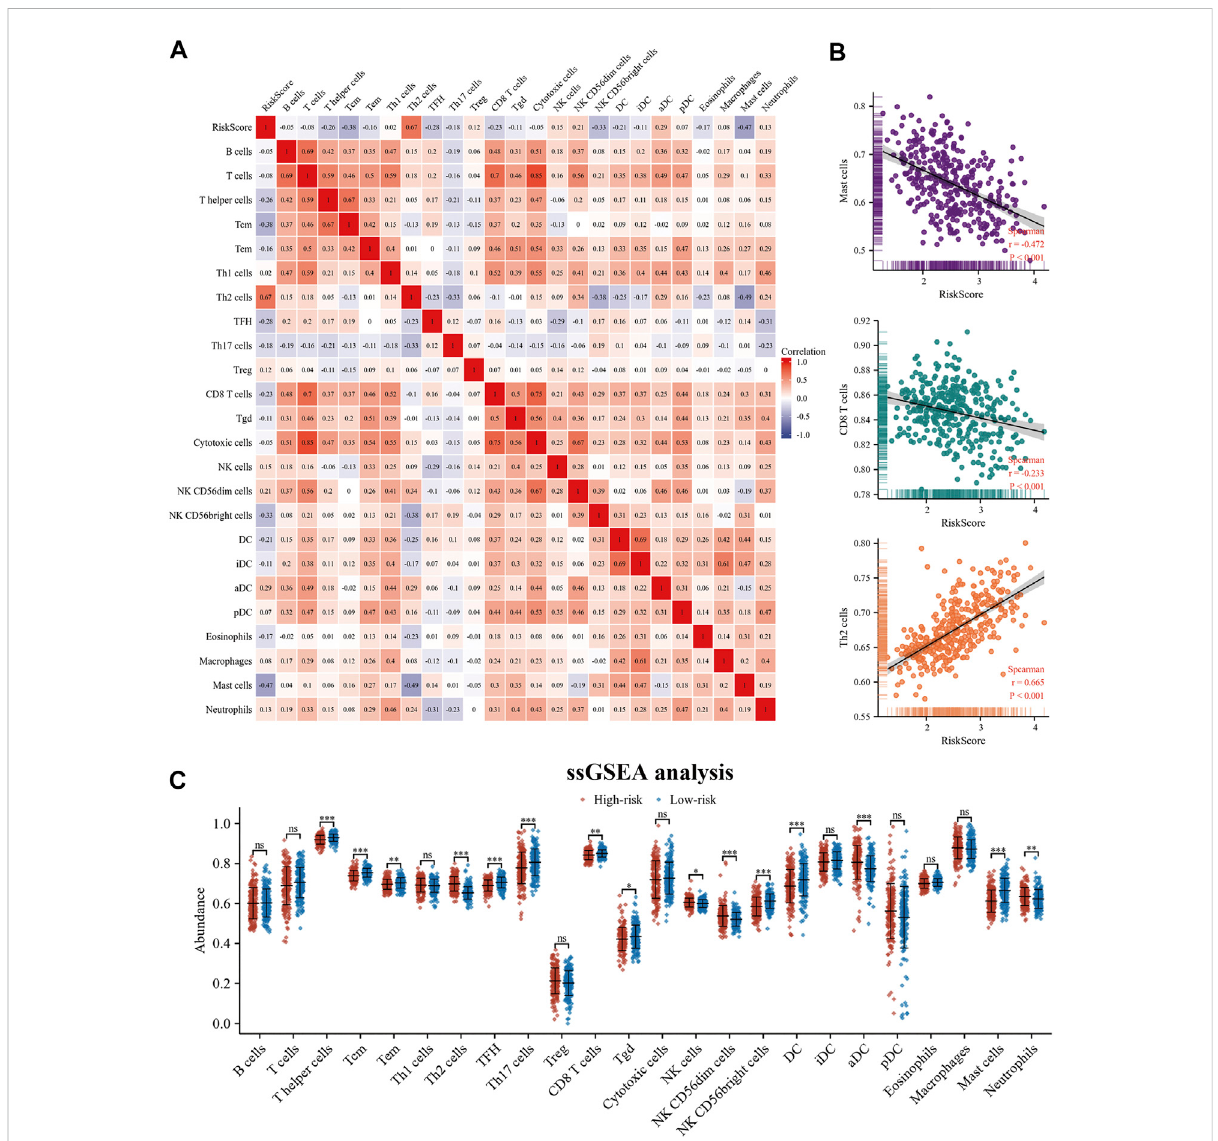
sample Gene Set Enrichment